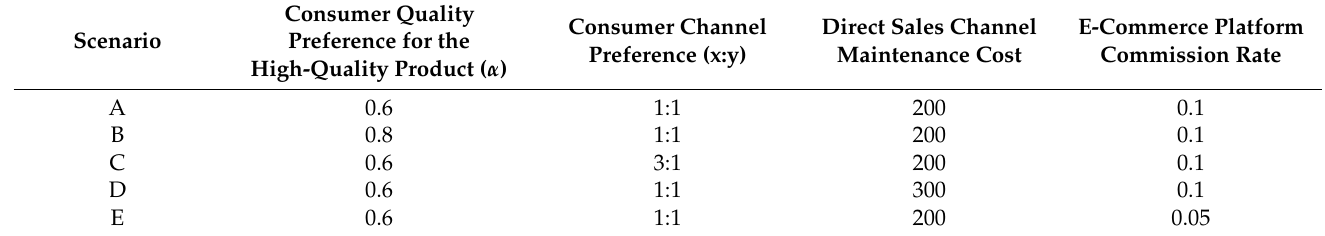
Table 3. Different scenarios.